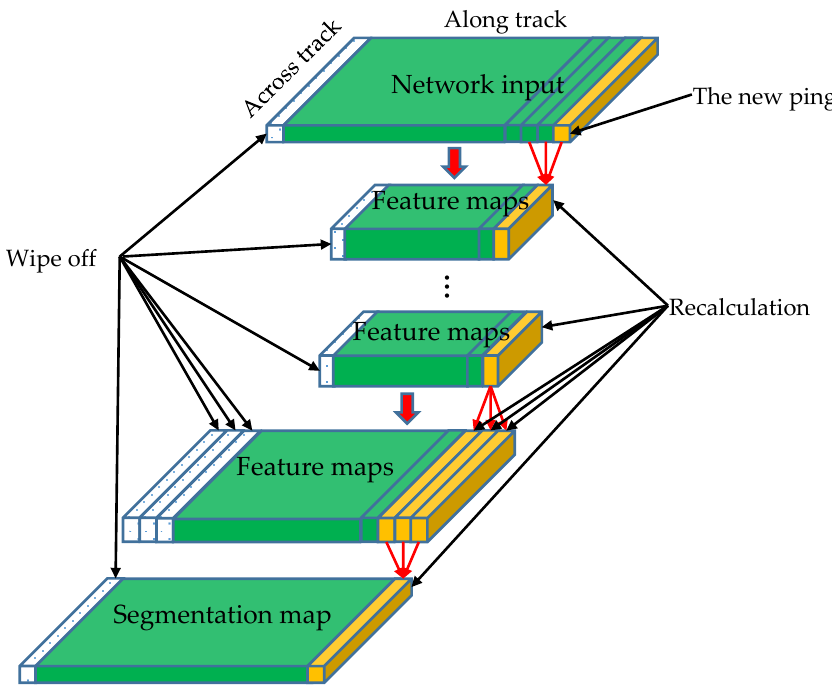
Figure 18. The schematic diagram of real-time tracking based on the PM.